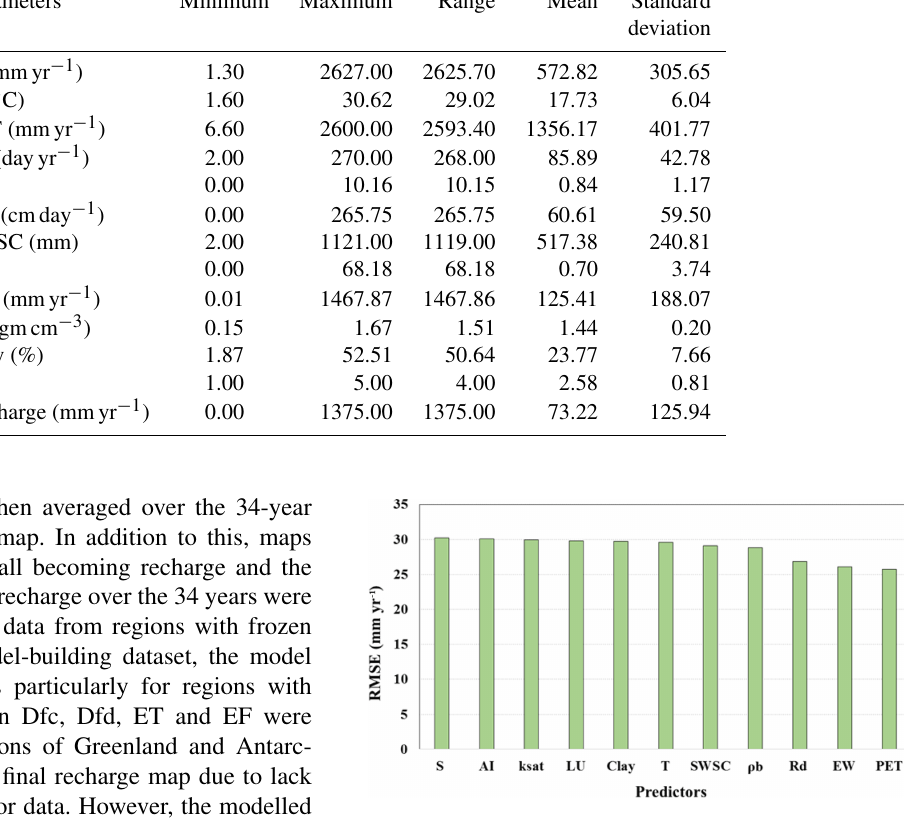
Table 2. Summary statistics of potential predictors from the dataset used in this study. Parameters Minimum Maximum Range